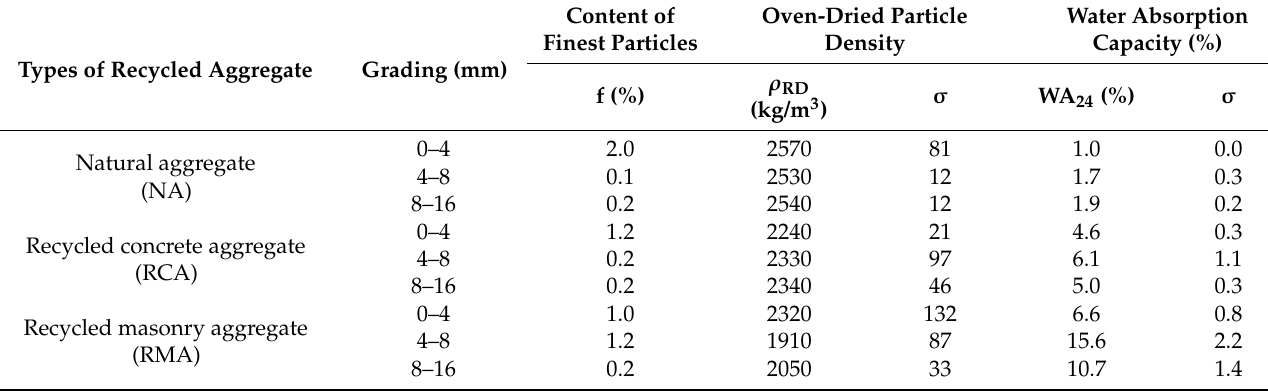
Figure 2. Recycled concrete aggregate (RCA) and recycled masonry aggregate (RMA) of fraction 0–4, 4–8 and 8–16 mm. Table 1. Physical properties of particular fractions of used